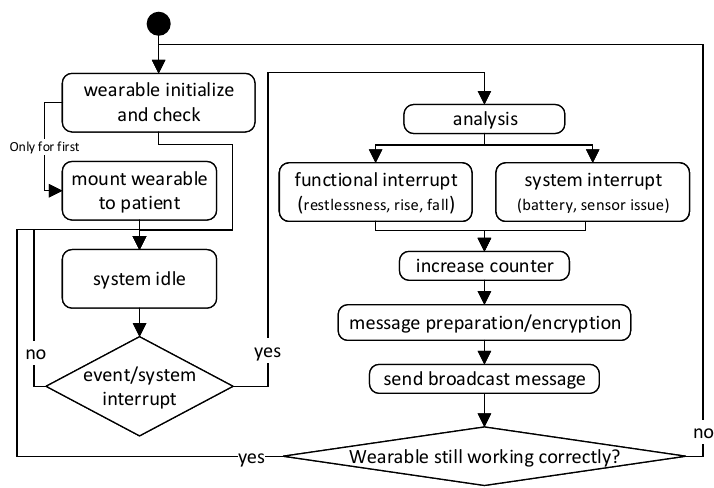
Figure 2. Flowchart of the INBED wearable internal process.